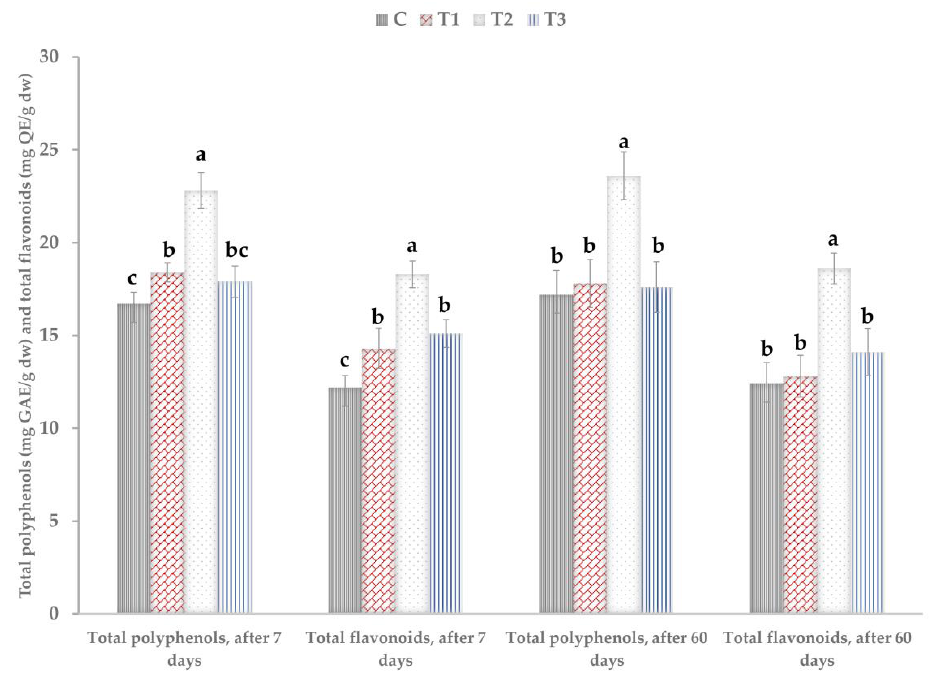
Figure 4. Total polyphenols (mg GAE / g dw) and total flavonoids (mg QE / g dw) in the hydroalcoholic extractsfromaerialpartsofthe P.caerulea plantsaftersevendaysfromthefirsttreatmentandafter60days from the first treatment with plant biostimulants. C—control (no treatment with plant biostimulants, treatment only with water); T 1 —foliar treatment with Trichoderma consortium suspension, 10 6 cfu / mL, equiv. to 10 11 spores / ha; T 2 —foliar treatment with Trichoderma consortium suspension, 10 8 cfu / mL, equiv. to 10 13 spores / ha; T 3 —foliar treatment with a reference product, consisting of plant extracts, essential oils, and fatty acids in an oil / water emulsion, and extract of the seaweed Ascophyllum nodosum , equiv. to 3 L / ha. Values presented are means ± standard error ( n = 12 replicates). Columns labeled with di ff erent letters within each parameter are significantly di ff erent at p <